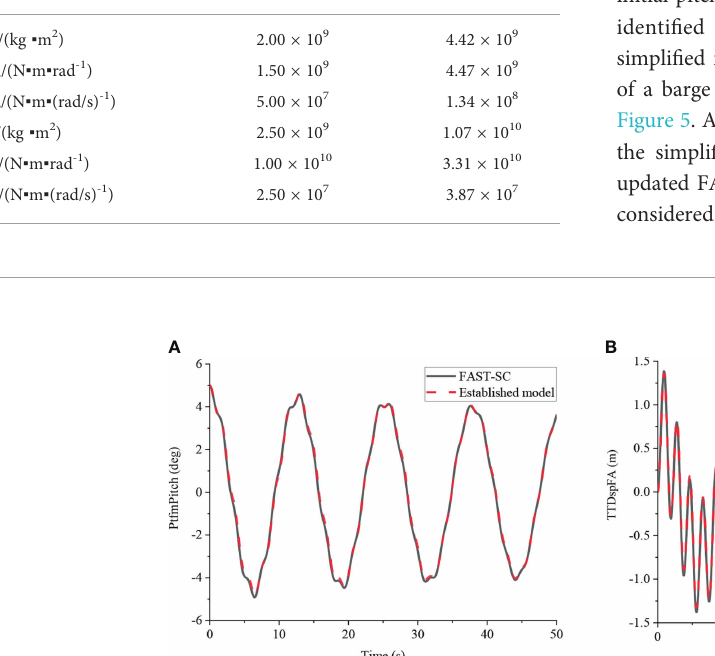
TABLE 3 Initial estimated and identi fi ed values of the unknown parameters.